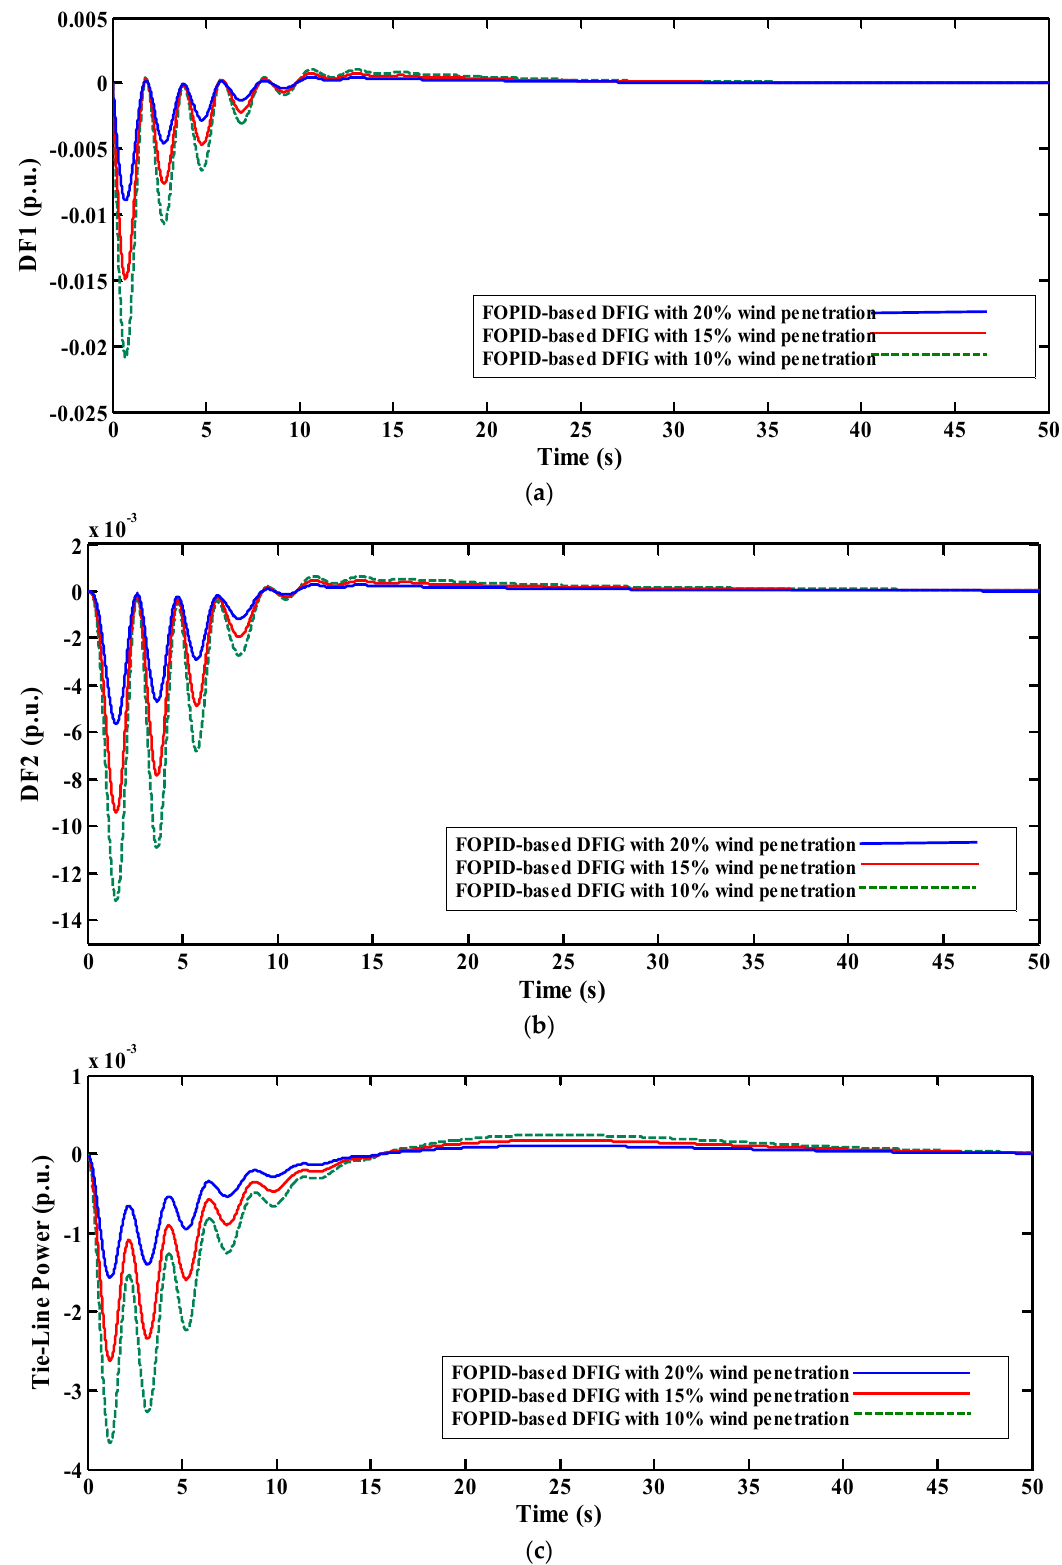
Figure 6. Frequency deviation and tie-line active power change in second scenario, ( a ) frequency deviation in area 1; ( b ) frequency deviation in area 2; and ( c ) tie-line power deviation.